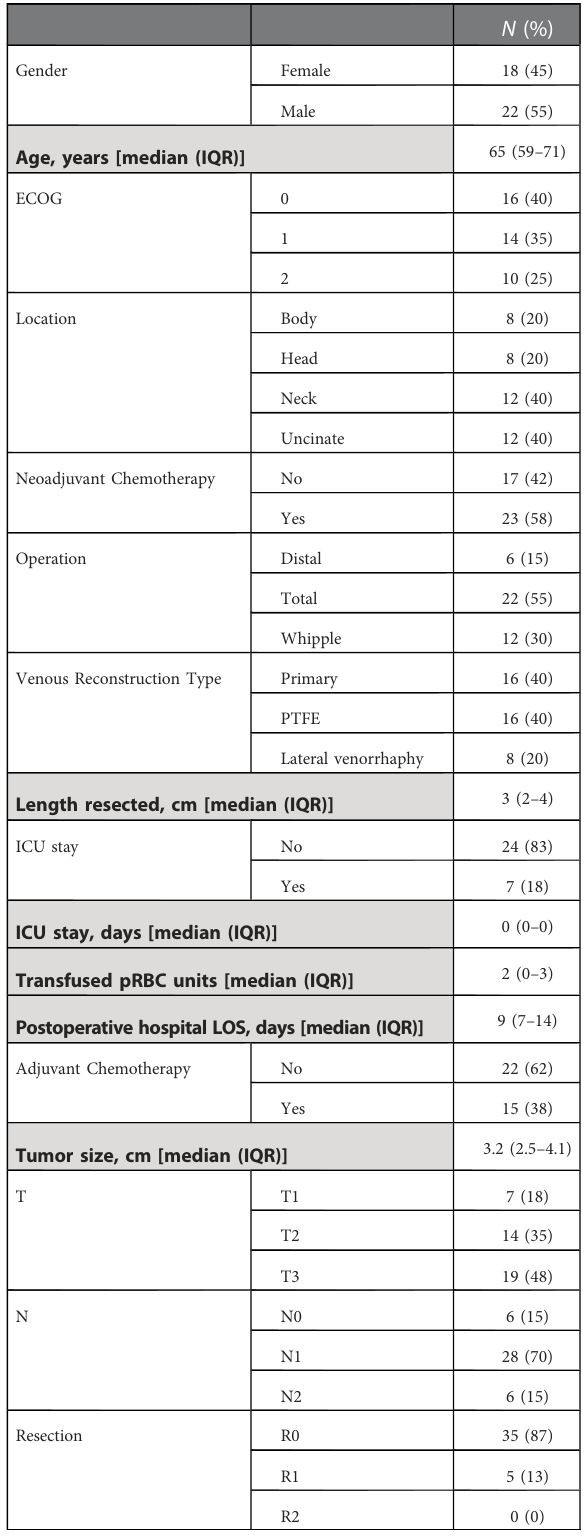
TABLE 1 Clinicopathologic characteristics of 40 patients who underwent pancreatectomy with PV/SMV resection for BR/LA PC. ICU: intensive care unit, LOS: length of stay, LN: lymph